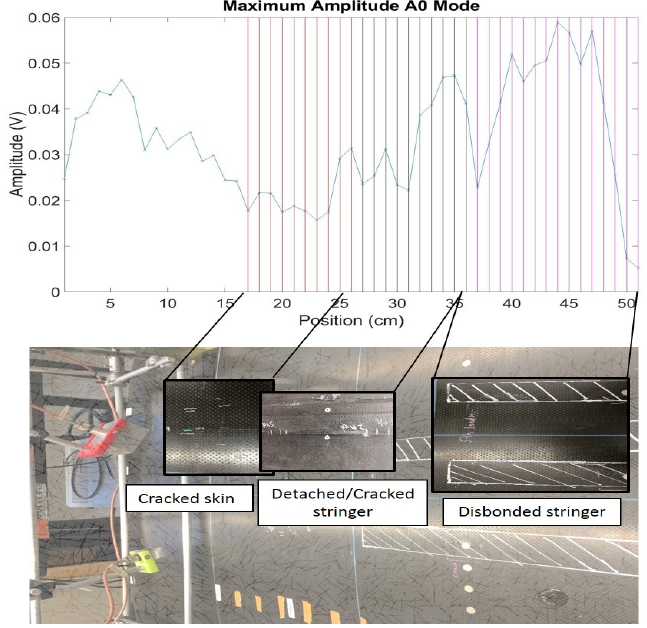
Figure 10. Maximum amplitude from non-contact UGW scans: Panel 3.